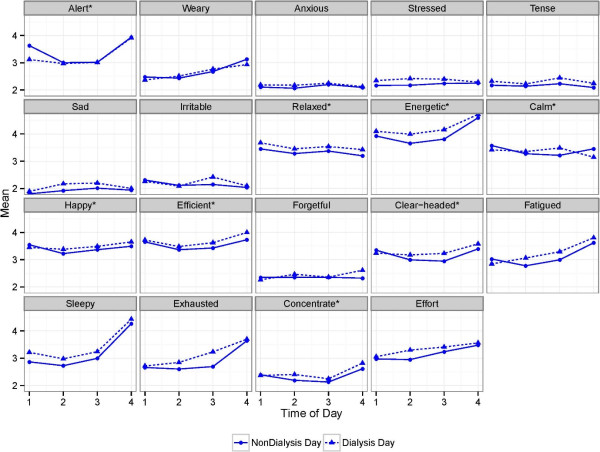
Daily and diurnal symptom variation. Higher scores indicate greater endorsement of listed symptom. Except as noted, items are of the form, “How _____ do you feel?” *Items were reverse coded so that higher scores would indicate greater symptom burden (e.g., “How happy do you feel?” was reverse coded to create “not happy”) Concentrate: actual wording is, “How well are you able to concentrate?” Effort: actual wording is, “How much of an effort is it to do anything?”.